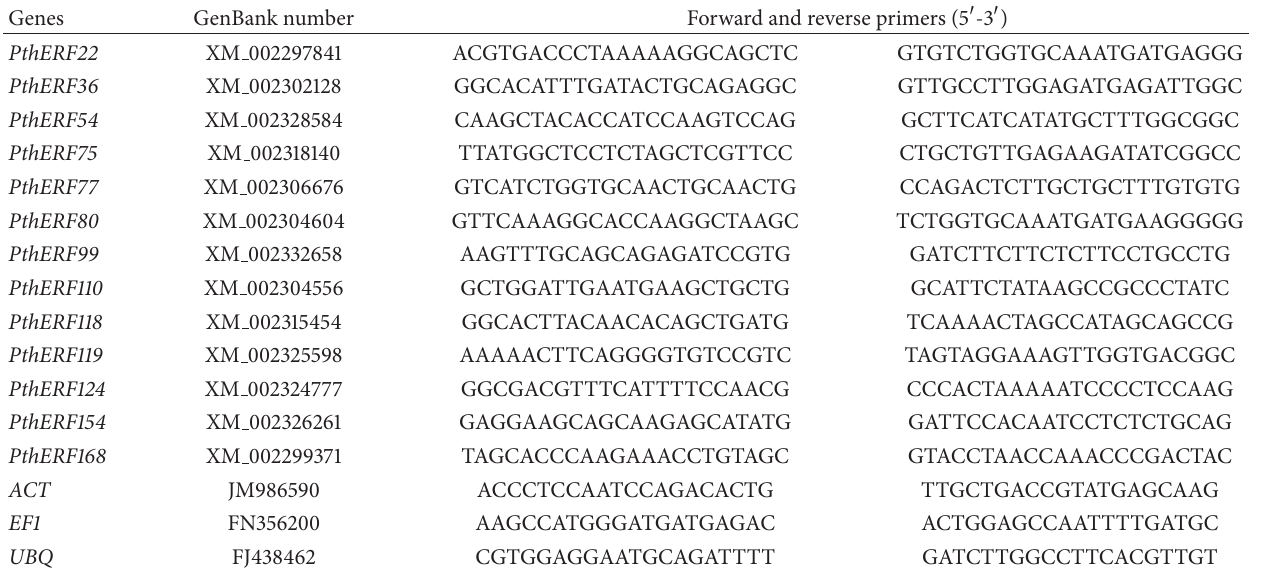
Table 1: Primers used in real time